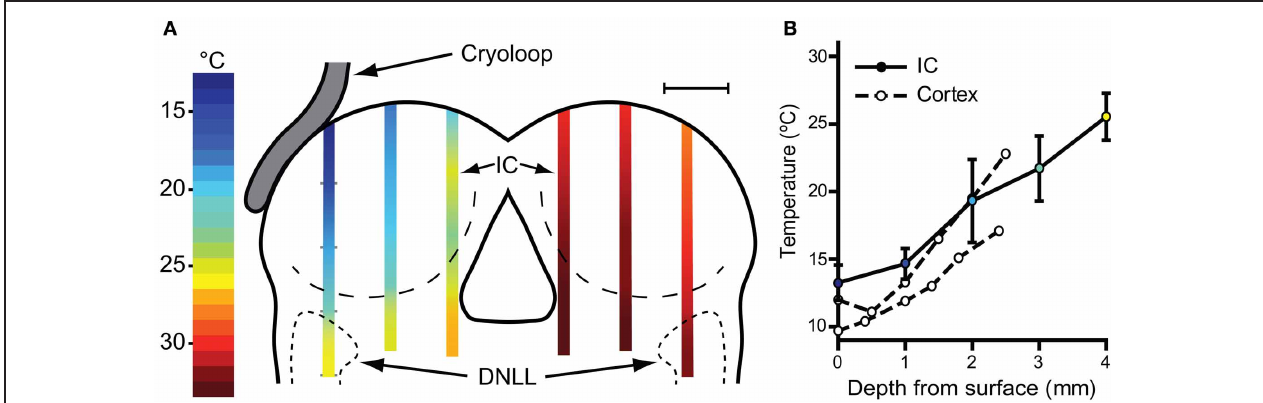
FIGURE 2 | (A) Schematic coronal section through the IC showing placement of the cryoloop and temperatures measured in the IC with a needle thermocouple during cooling in the left (cooled) and right IC. These measurements were made after removal of the overlying cortex. For electrophysiological recording experiments the cortex over the right IC was left